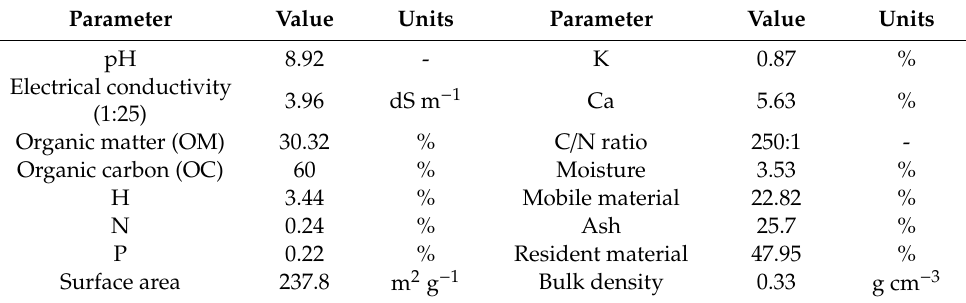
Table 3. Physical and chemical properties of the biochar.